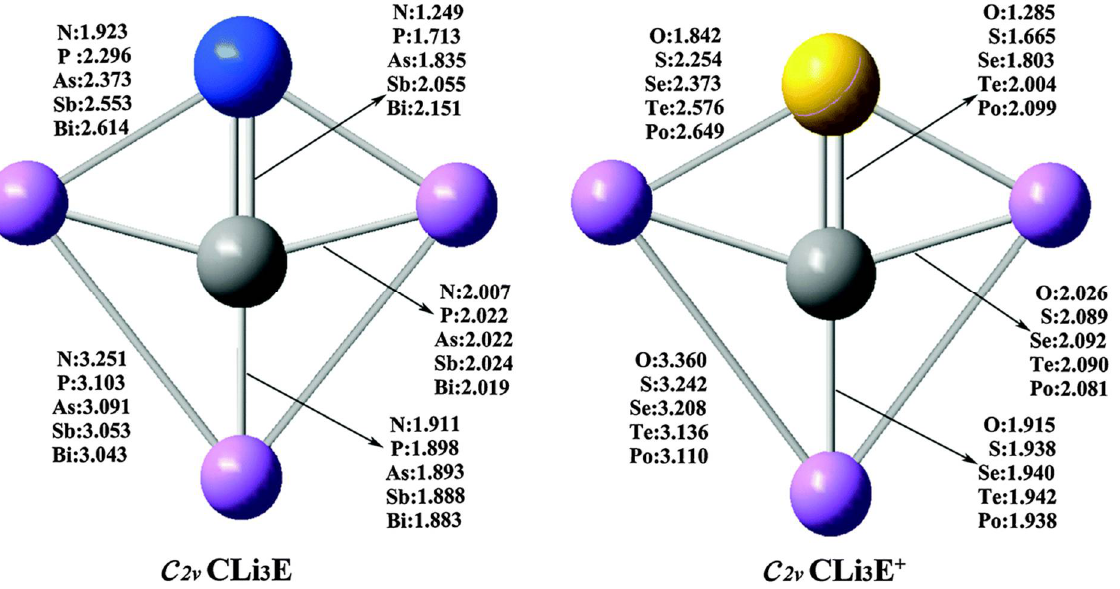
Figure 9. The optimized geometries of C 2 v CLi 3 E (E = N, P, As, Sb, Bi) and CLi 3 E + (E = O, S, Se, Te, Po) at the MP2/aug-cc-pVTZ level. Bond distances are in Å. Reprinted from ref. [88] with permission from Royal Society of Chemistry.